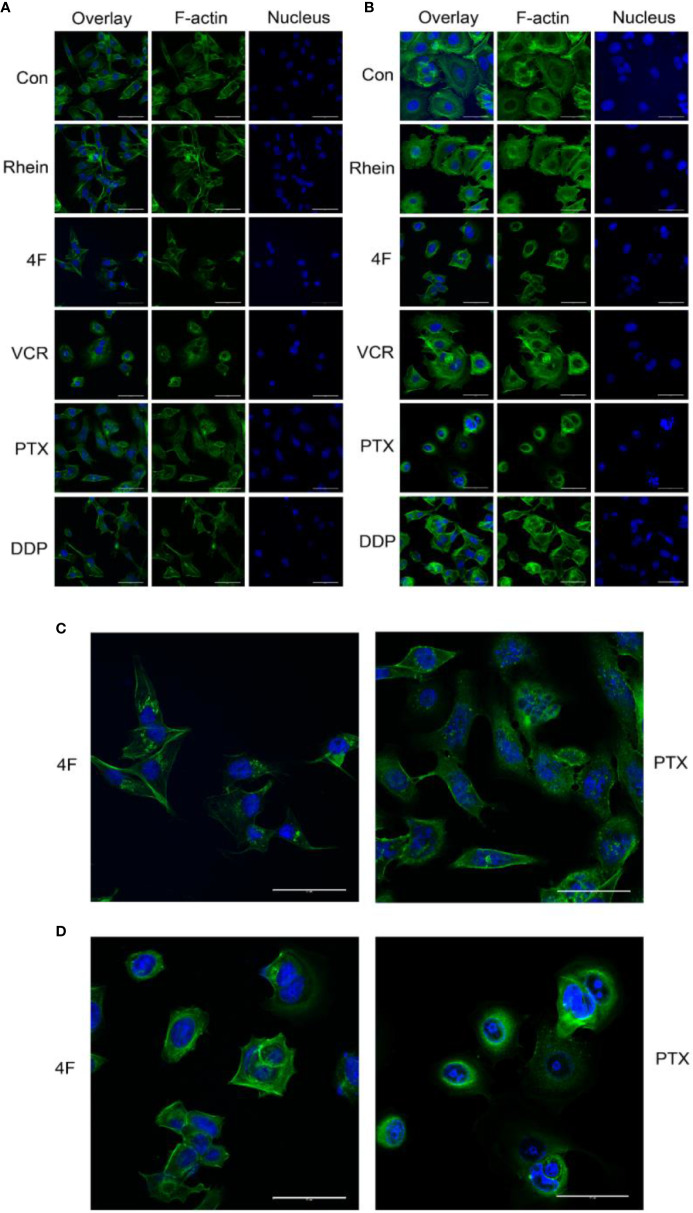
Laser confocal microscopy to detect the effects of different drugs on the cytoskeleton of breast cancer cells (scale bar: 50 μm). F-actin and the nucleus appear in green and blue, respectively. (A) Cytoskeletal changes after drug treatments in MDA-MB-231 cells. (B) Cytoskeletal changes after drug treatments in MCF-7 cells. (C) MDA-MB-231 cells treated with derivative 4F and PTX (scale bar: 50 μm). (D) MCF-7 cells treated with derivative 4F and PTX (scale bar: 50 μm).